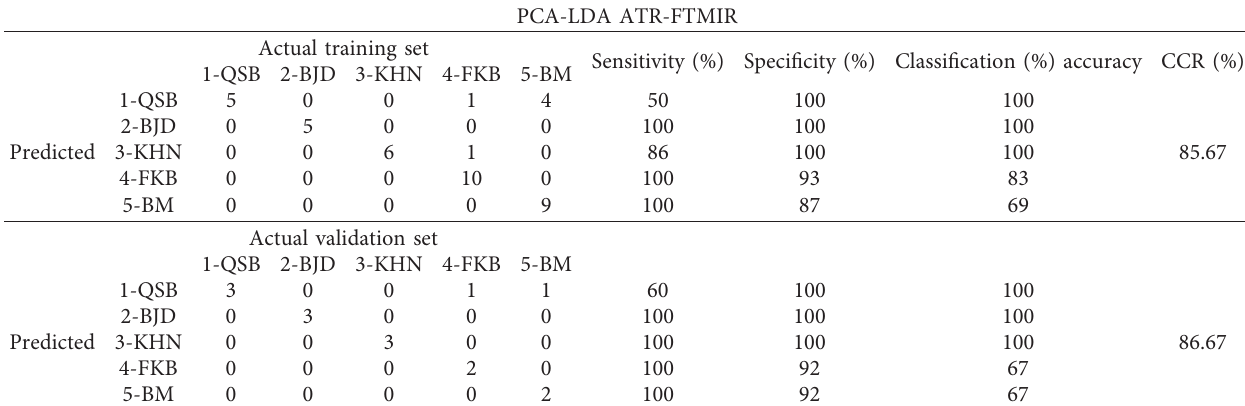
Table 3: Confusion matrix of PCA-LDA results on the first four principal components of ATR-FTMIR spectral data.